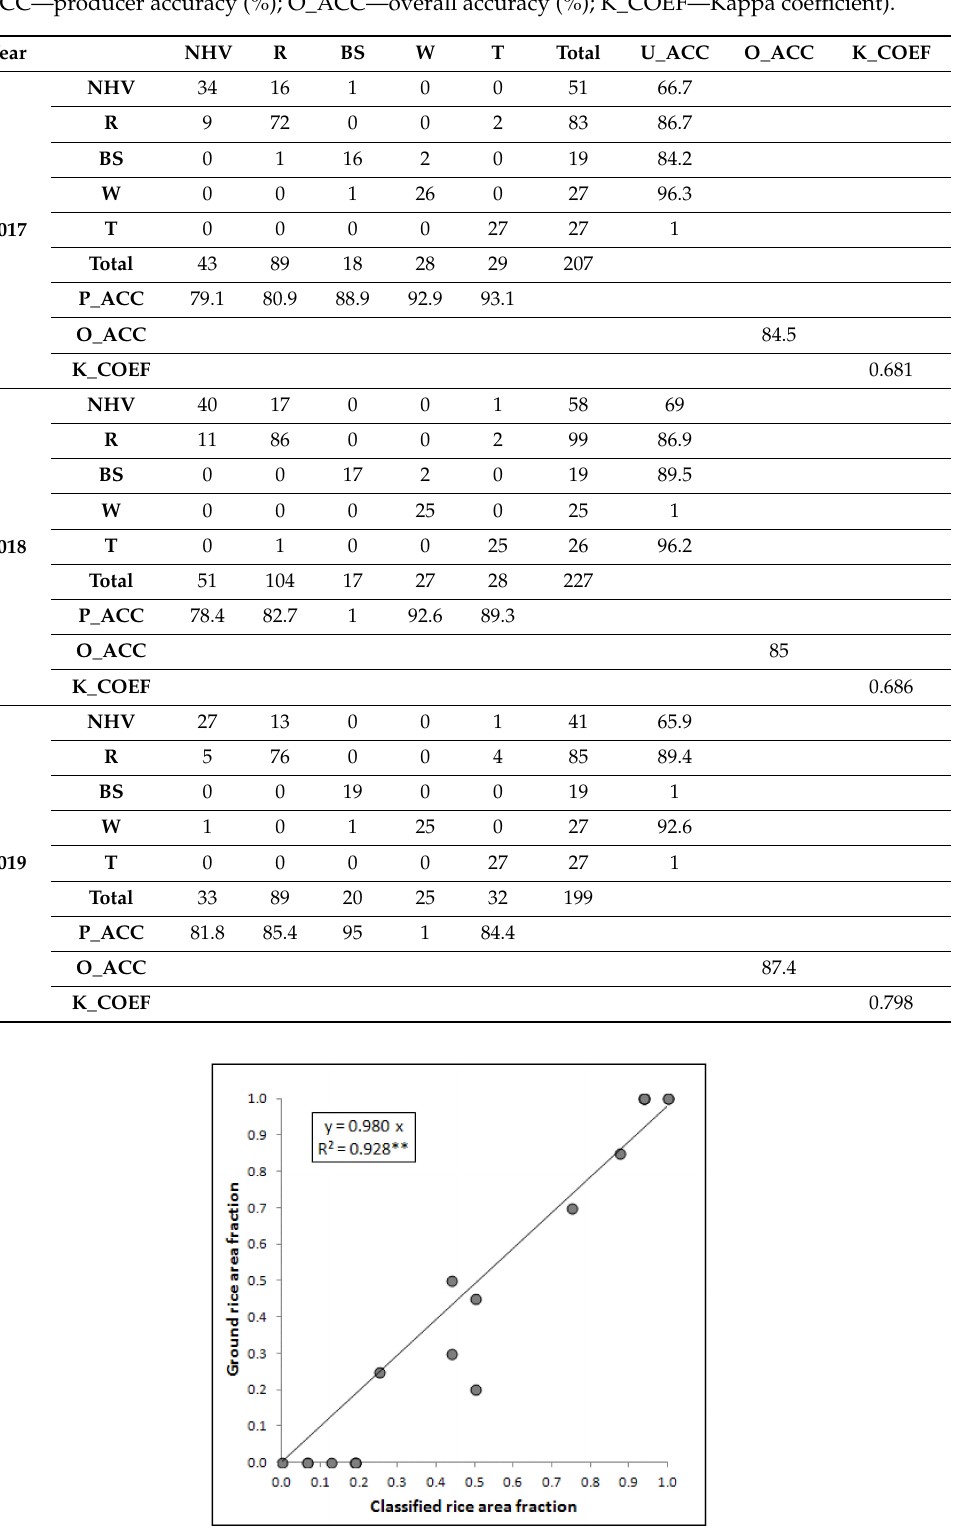
Table 4. Confusion matrices of lowland land cover maps in 2017, 2018, and 2019 rice growing seasons (NHV—natural herbaceous vegetation; R—rice; B—bare soil; T—trees; U_ACC—user accuracy (%);